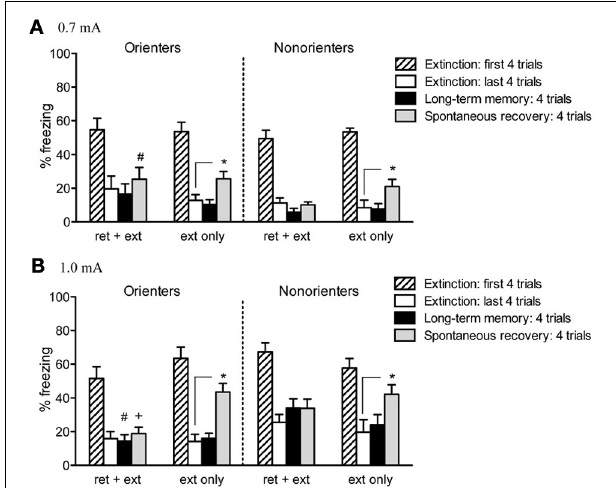
FIGURE 4 | Cue-induced freezing at the beginning of extinction, end of extinction, during LTM test, and spontaneous recovery. (A) For rats conditioned with a 0.7mA shock, a retrieval trial prevented spontaneous recovery (i.e., there was no significant increase in freezing from the end of extinction to spontaneous recovery test; Orienters p = 0 . 206, Non-orienters p = 0 . 732). While neither group showed significant spontaneous recovery, Non-orienters froze significantly less than Orienters during the test for spontaneous recovery ( # p = 0 . 041). Rats receiving typical extinction treatment did show a significant increase in freezing (Orienters p = 0 . 014, Non-orienters p = 0 . 032). (B) Rats conditioned with a 1.0mA shock showed the same pattern of results: a retrieval trial prior to extinction attenuated spontaneous recovery (Orienters p = 0 . 524, Nonorienters p = 0 . 235). Rats exposed to typical extinction showed a significant increase in freezing (Orienters p < 0 . 001, Non-orienters p = 0 . 032). While neither Orienters nor Non-orienters that received ret + ext showed significant increases in freezing from the end extinction to LTM or spontaneous recovery tests, Orienters showed significantly less freezing than Non-orienters at both time points (LTM # p = 0 . 011, spontaneous recovery + p = 0 .